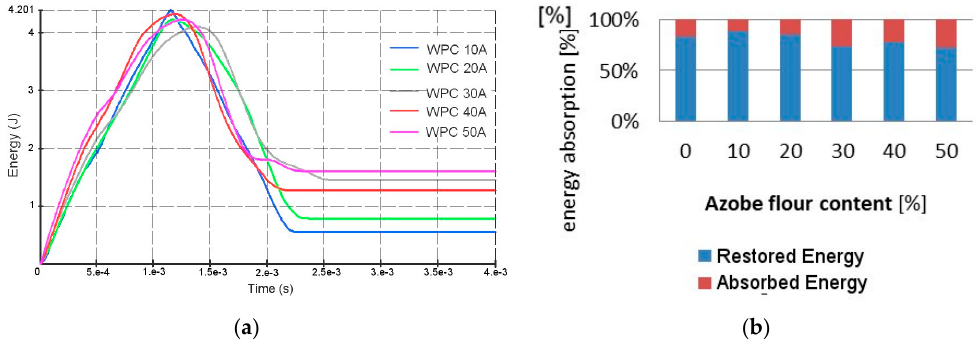
Figure 7. Absorbed energy ( a ) energy absorption rate ( b ) for each fabricated Azobé/UF WPC